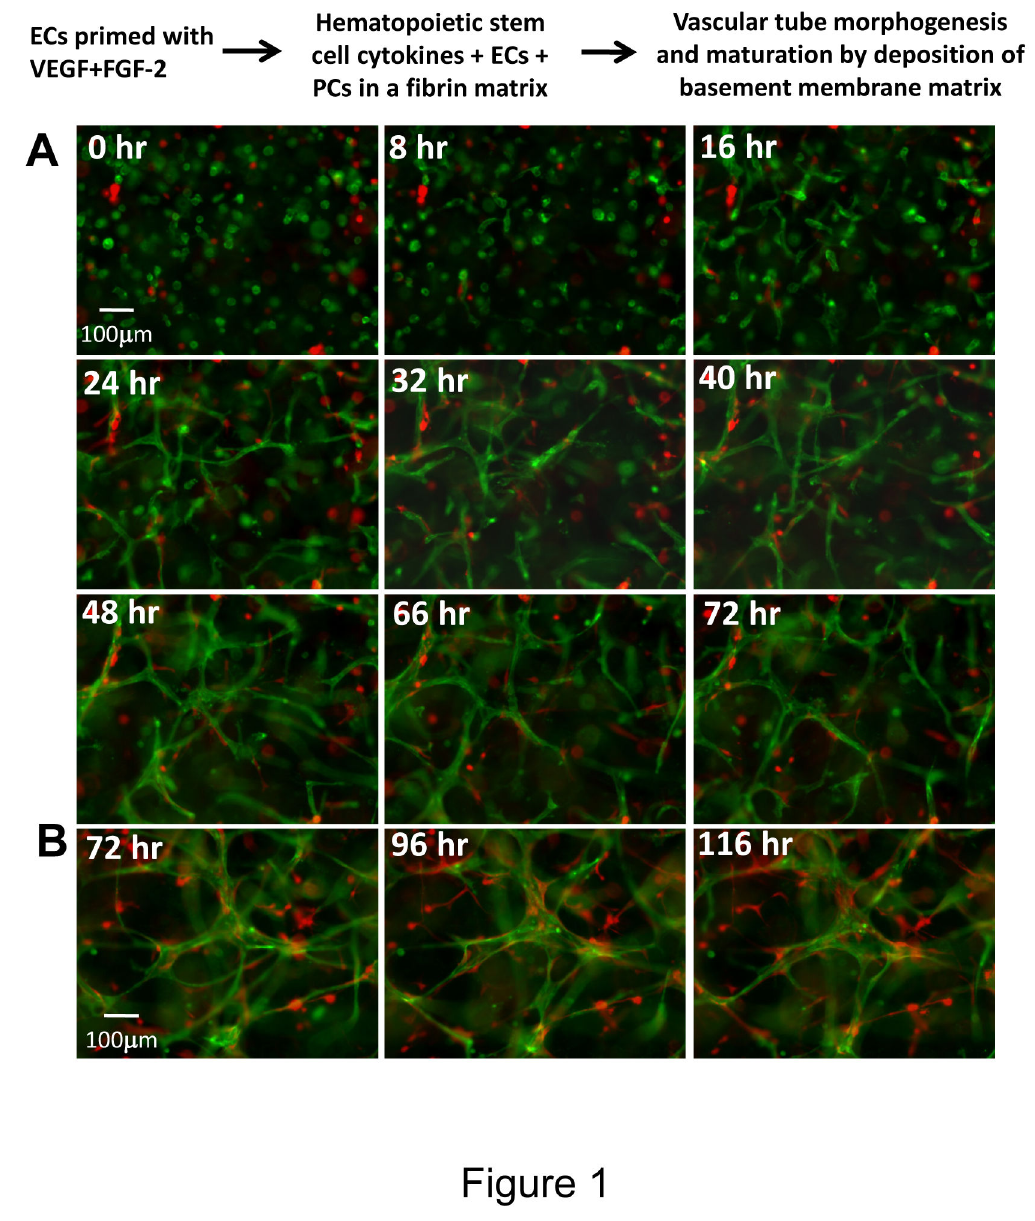
Figure 1. Real-time images showing endothelial cell tube formation and pericyte recruitment using a serum-free defined system in 3D fibrin matrices. Hematopoietic stem cell cytokines and FGF-2 stimulate these morphogenic responses which can be primed by EC pre-treatment with VEGF and FGF-2. Endothelial cells (ECs) were labeled with membrane targeted GFP while pericytes (PCs) were labeled with mCherry. The two cell types were randomly mixed into fibrin matrices in the presence of SCF, IL-3, SDF-1α, Flt-3L and FGF-2. Prior to harvesting the cells for suspension into fibrin gels, ECs were primed with VEGF and FGF-2 for 20 hr. After fibrin polymerization, cultures were imaged every 10 minutes and select fluorescent images are shown at the indicated times. Two different series (A,B) are illustrated. Bar equals 100 µm. doi: 10.1371/journal.pone.0085147.g001 Hematopoietic stem cell cytokines in conjunction with tube structures with abluminally associated pericytes in 3D FGF-2 stimulate human vascular tube morphogenesis fibrin matrices.